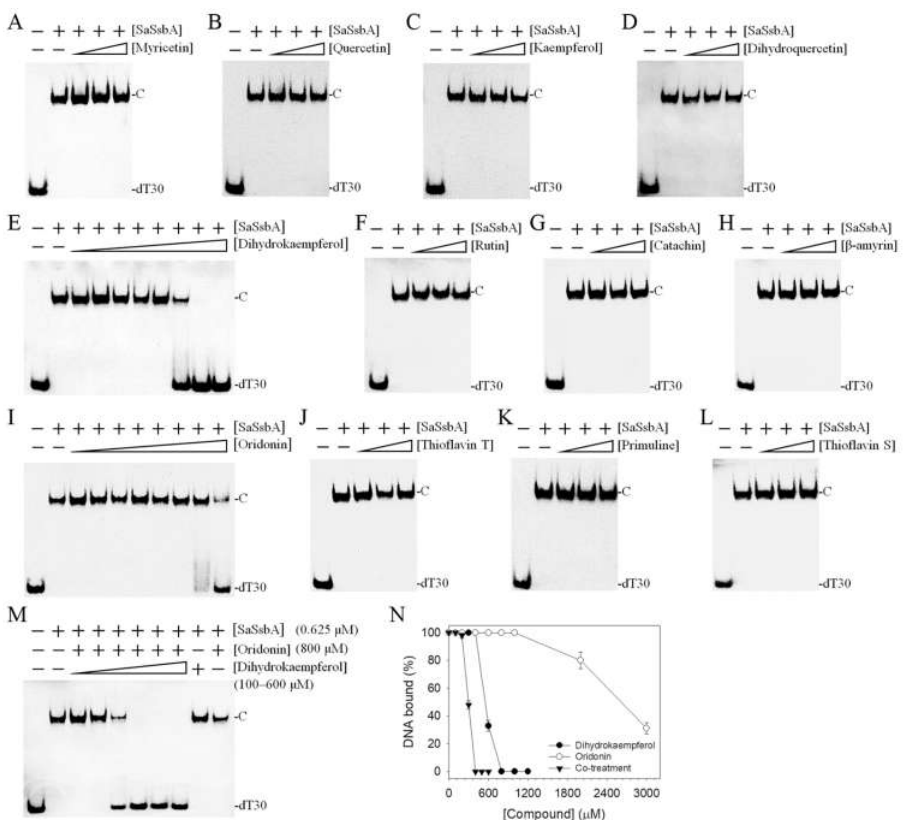
Figure 5. Inhibition of the ssDNA binding activity of SaSsbA. SaSsbA (0.625 μM) was incubated with ( A ) myricetin, ( B ) quercetin, ( C ) kaempferol, ( D ) dihydroquercetin, ( E ) dihydrokaempferol, ( F ) rutin, ( G ) catechin, ( H ) β-amyrin, ( I ) oridonin, ( J ) thioflavin T, ( K ) primuline, and ( L ) thioflavin S. These compounds were dissolved in 10% dimethyl sulfoxide (DMSO). The flavanonol dihydrokaempferol and the diterpenoid oridonin were able to inhibit SaSsbA. ( M ) Co-treatment of oridonin (800 μM) and dihydrokaempferol (0–600 μM) for the inhibition of SaSsbA. ( N ) IC 50 determinations for SaSsbA.